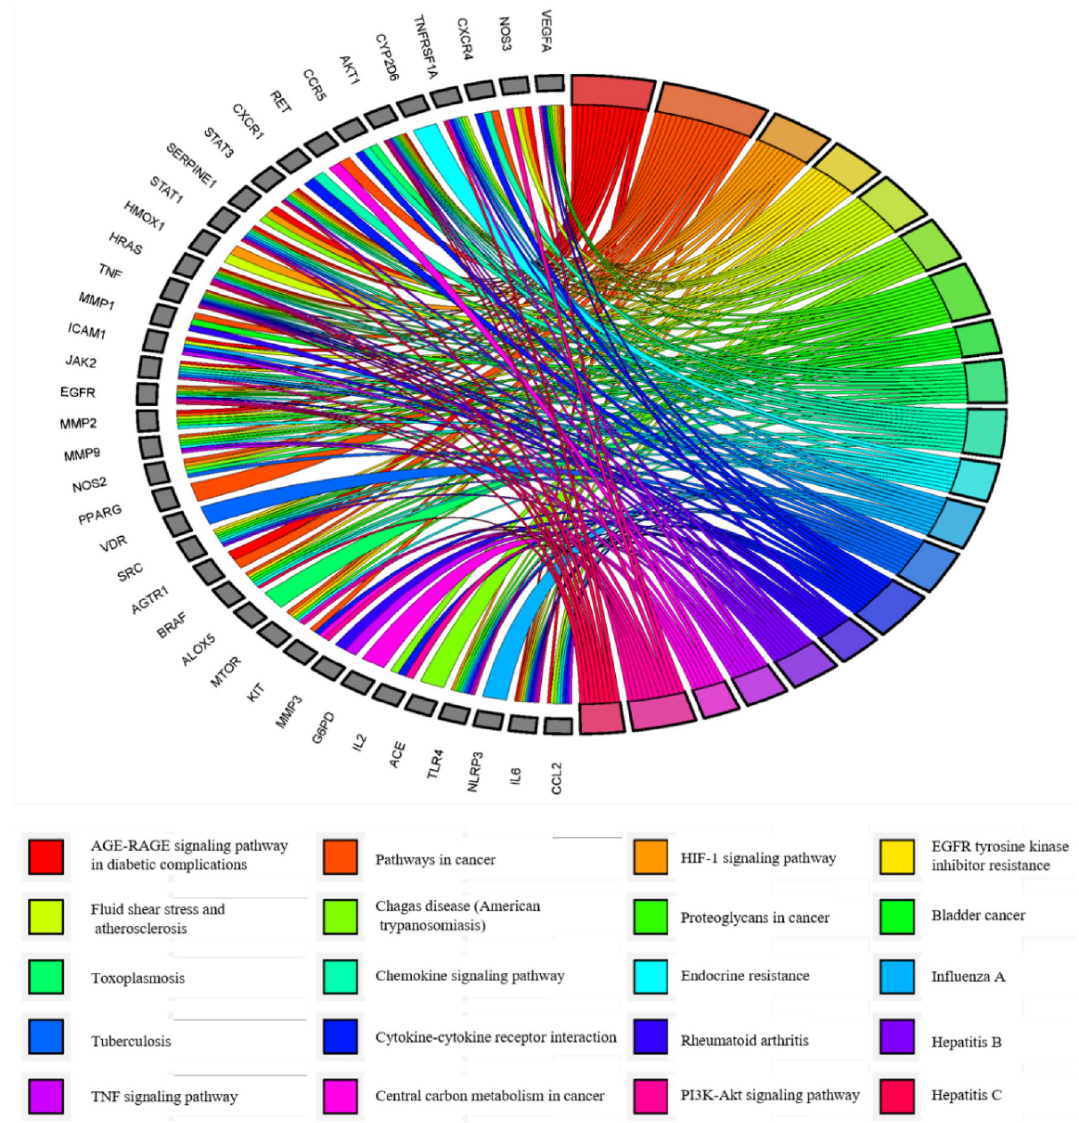
Figure 4. The top 20 pathways of KEGG enrichment analysis for 59 overlapping